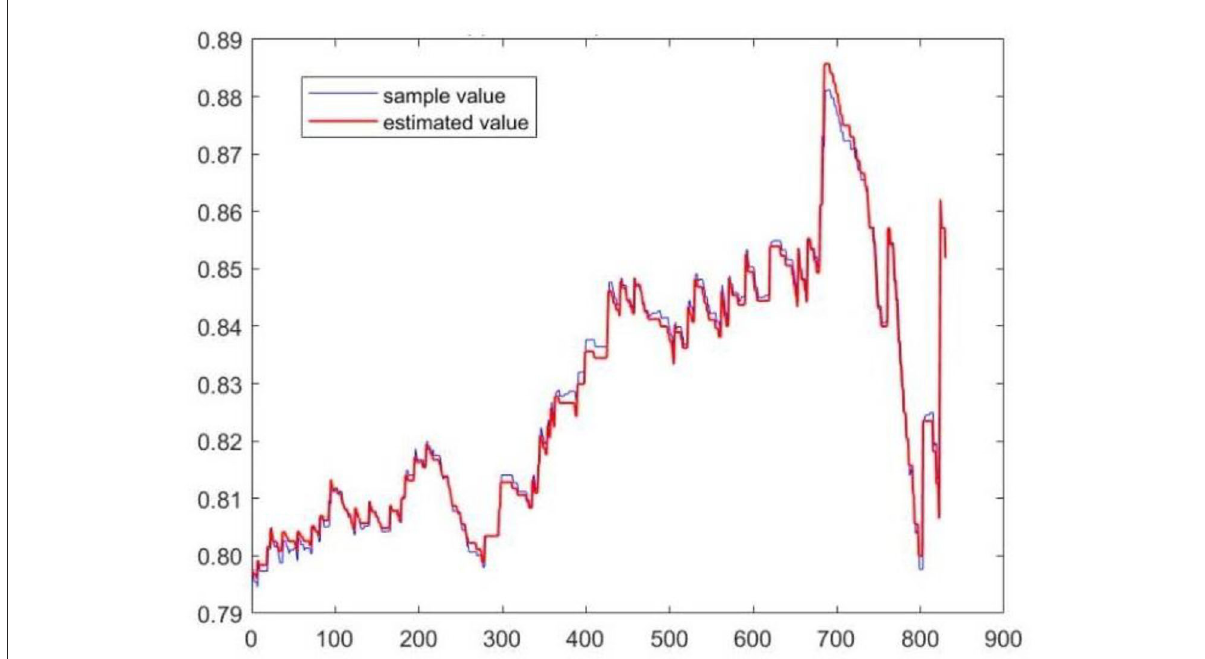
FIGURE2 A dynamic diagram of statistics and estimates of upper-tail-dependence coefficients.